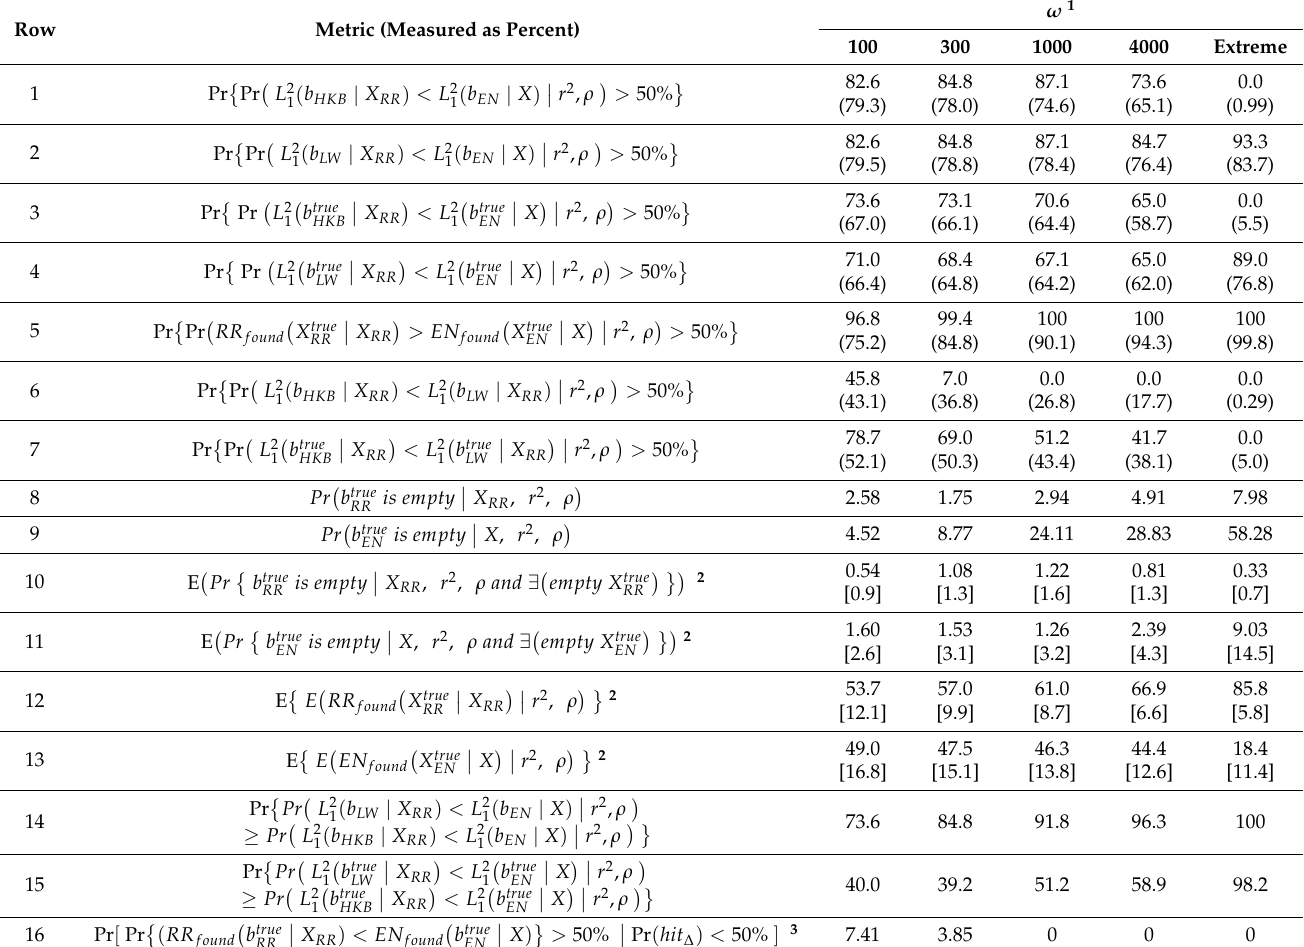
Table 2. RR vs. EN over all combinations of r 2 and ρ by ω , at α =